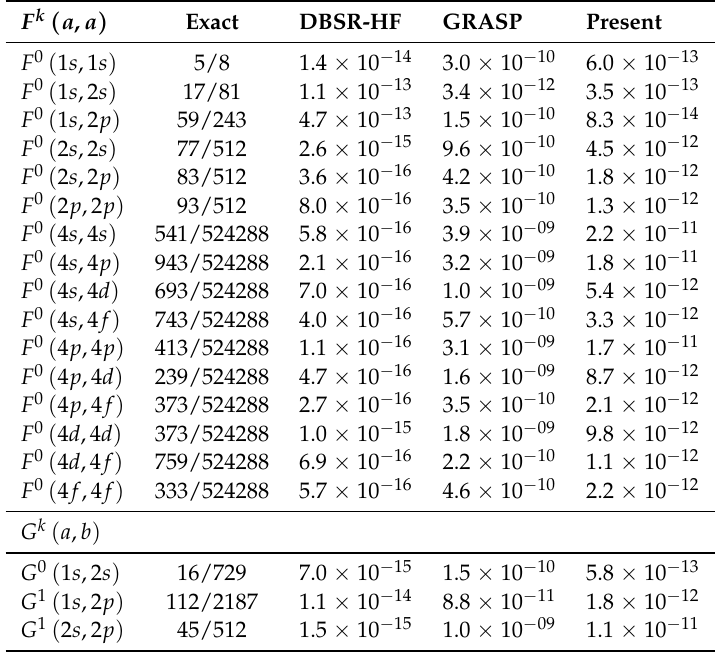
Table 4. Present errors for non-relativistic Slater integral values for hydrogenic functions compared with GRASP and